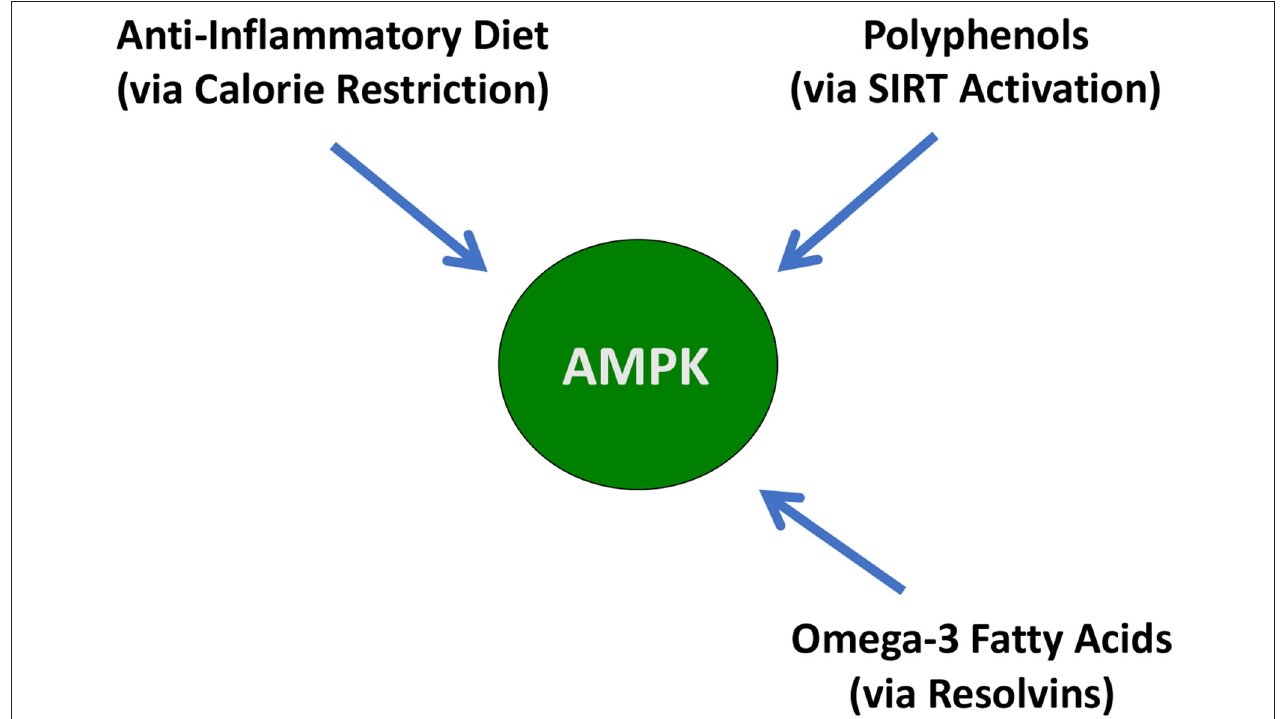
FIGURE 6 | A graphical description of the dietary interventions that can activate